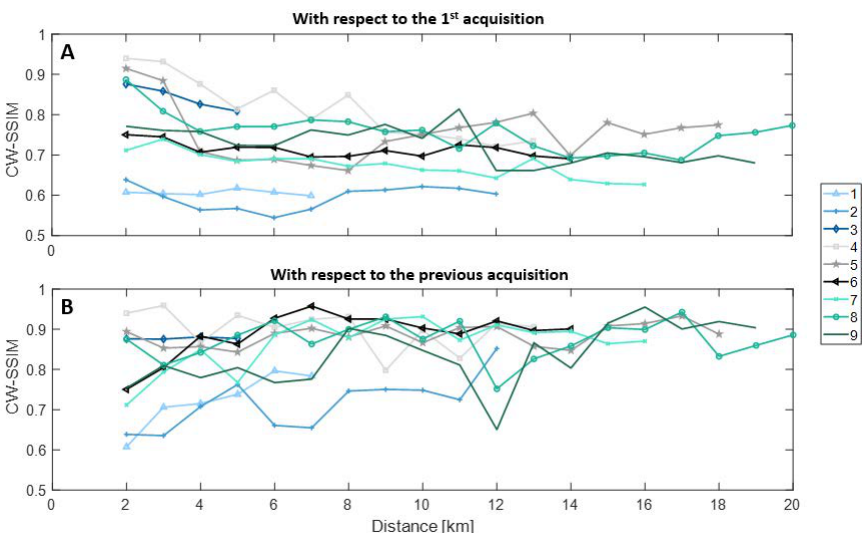
Figure 4. Field-of-view stability. ( A ) The complex-wavelet structural similarity index method values of each acquisition with respect to the first acquisition obtained after the first kilometer. The difference between complex-wavelet structural similarity index method (CW-SSIM) indices between the last and second acquisition is on average 0.09. ( B ) The CW-SSIM indices with respect to the previous acquisition, which was on average 0.85. The CW-SSIM indices of volunteer 1 and 2 are relatively lower, which were acquired using a different